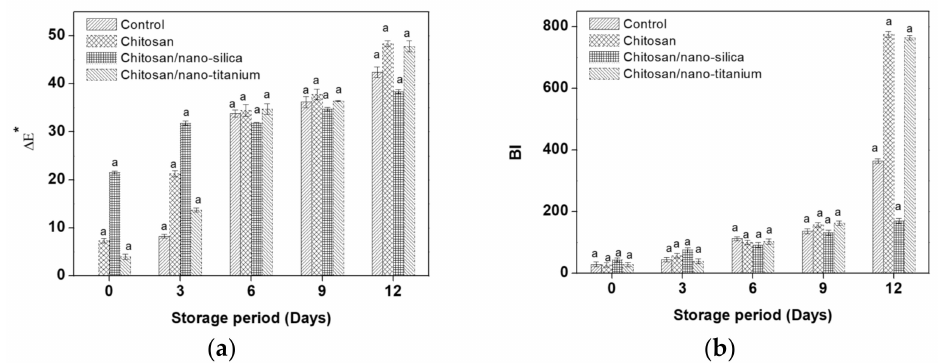
Figure 2. Effects of nano-films on ∆ E * ( a ) and BI ( b ) for white button mushrooms during storage at 4 ◦ C for 12 days. Data are mean ± SD, n = 3; a mean significant differences between treatments at p ≤